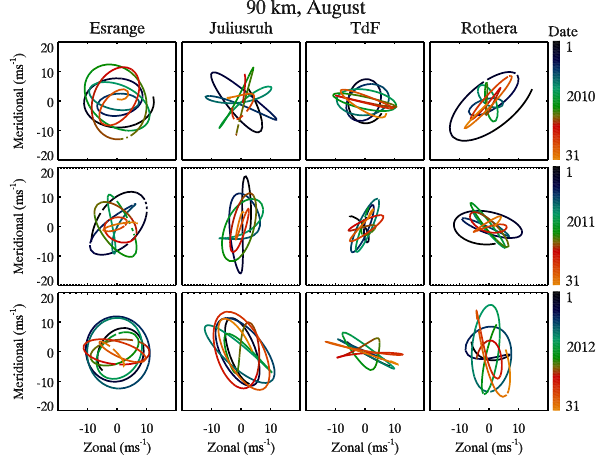
Figure 5. Hodographs of hourly 5DW winds at 90km for August in 2010, 2011, and 2012 from top to bottom. Esrange, Juliusruh, Tierra del Fuego, and Rothera are shown from left to